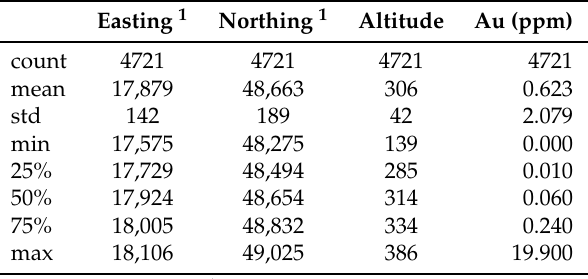
Table 1. Basic statistics of the composited dataset.